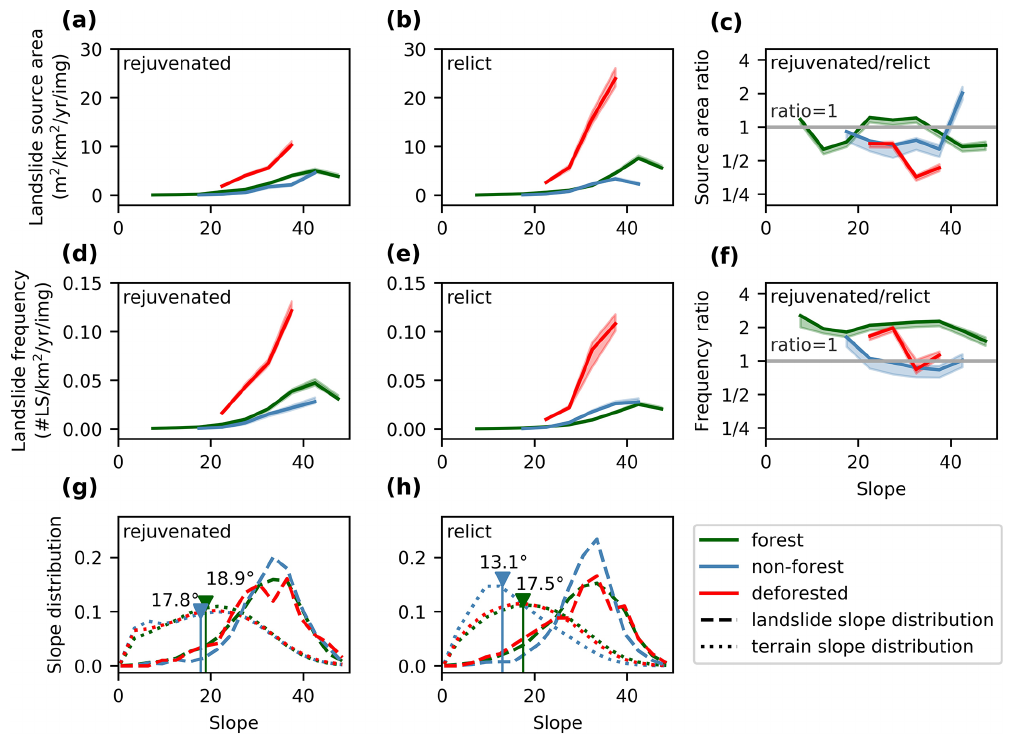
Figure 12. The effect of slope steepness and rejuvenation on landslide activity, corrected for imagery density. We only show results for slope classes in which we observed more than 20 landslides. (a) → (c) Landslide source area (LS S ) as a function of slope. (d) → (f) Landslide frequency (LS F ) as a function of slope. (g) → (h) Slope distribution for the terrain and landslides in the rejuvenated and relict landscapes. The blue and green arrows indicate the median slope in non-forest and forest landscapes. The slopes in rejuvenated landscapes are clearly steeper both in forest and non-forest land.